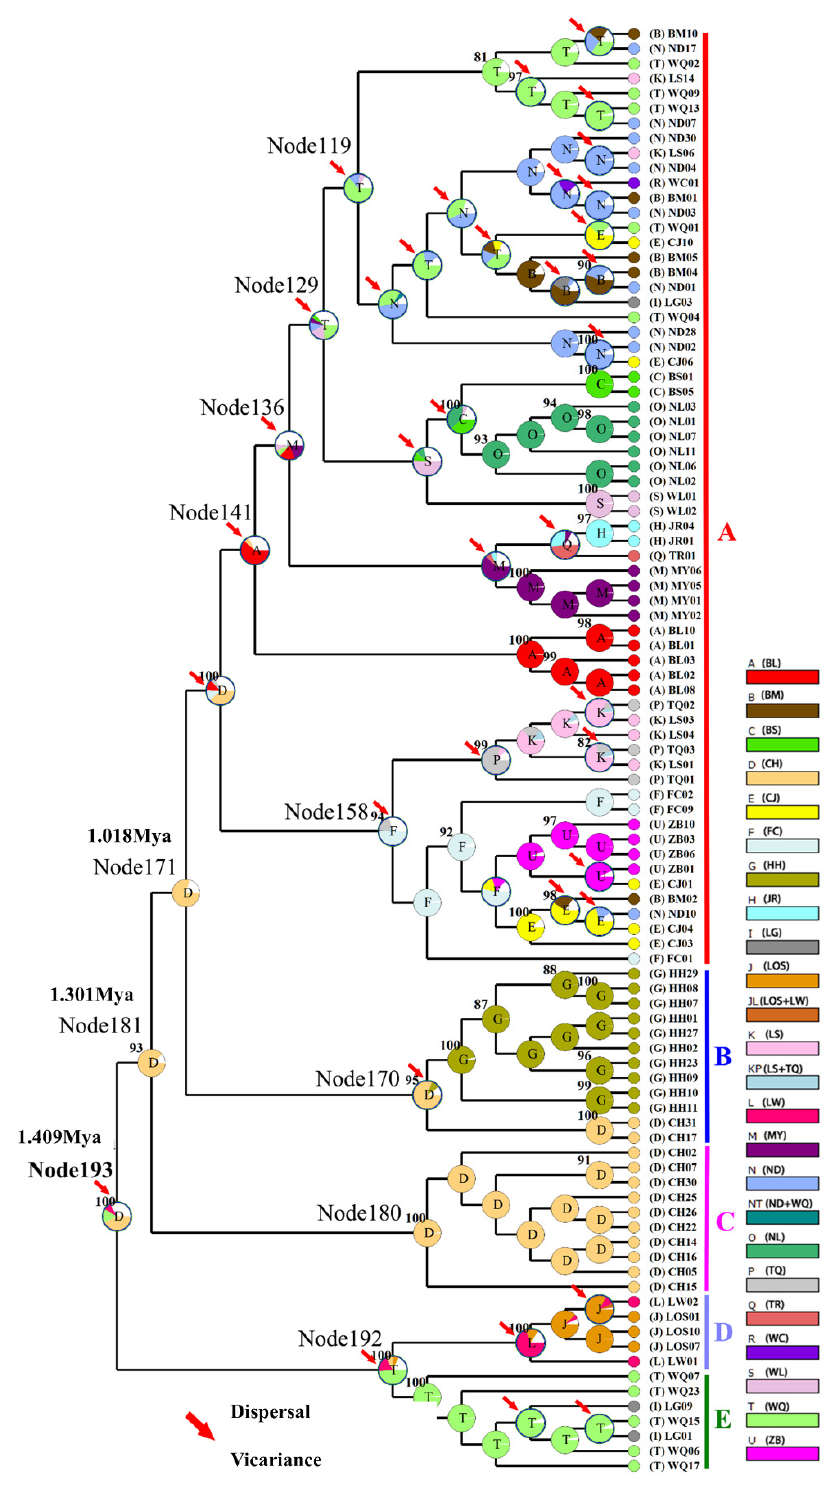
Figure 6. Ancestral states reconstructed by Bayesian binary MCMC (BBM) and plotted on the con- densed tree calculated by RASP. The BBM ancestral area reconstructions with the highest likelihood are shown as pie charts for each O. hainanensis clade. The color key for ancestral reconstruction at nodes of interest obtained from BBM analysis is provided in the figure. The numbers in the circles represent the node number. Pie charts depict ancestral area reconstruction probability, with the colors of pie slices defined in the legend. A–E represent the different lineages.